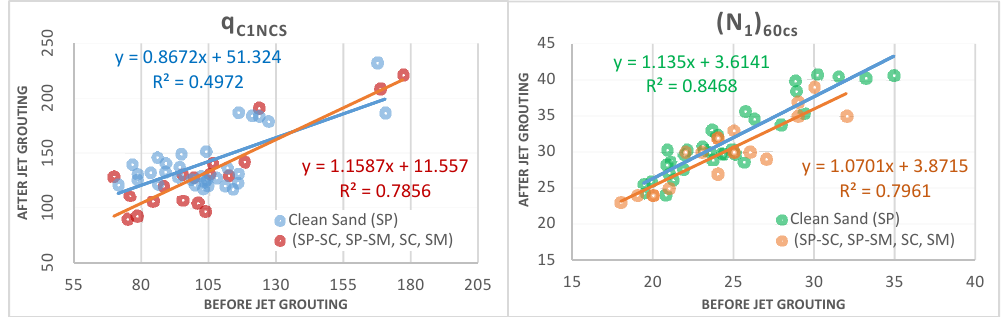
Figure 9. Relationships between q values ( left ) and ( N 1 ) values ( right ) before and after jet grouting using micropiles for coarse-grained clean sands (SP) and fine-grained soil SP-SC, SP-SM, SC, SM.